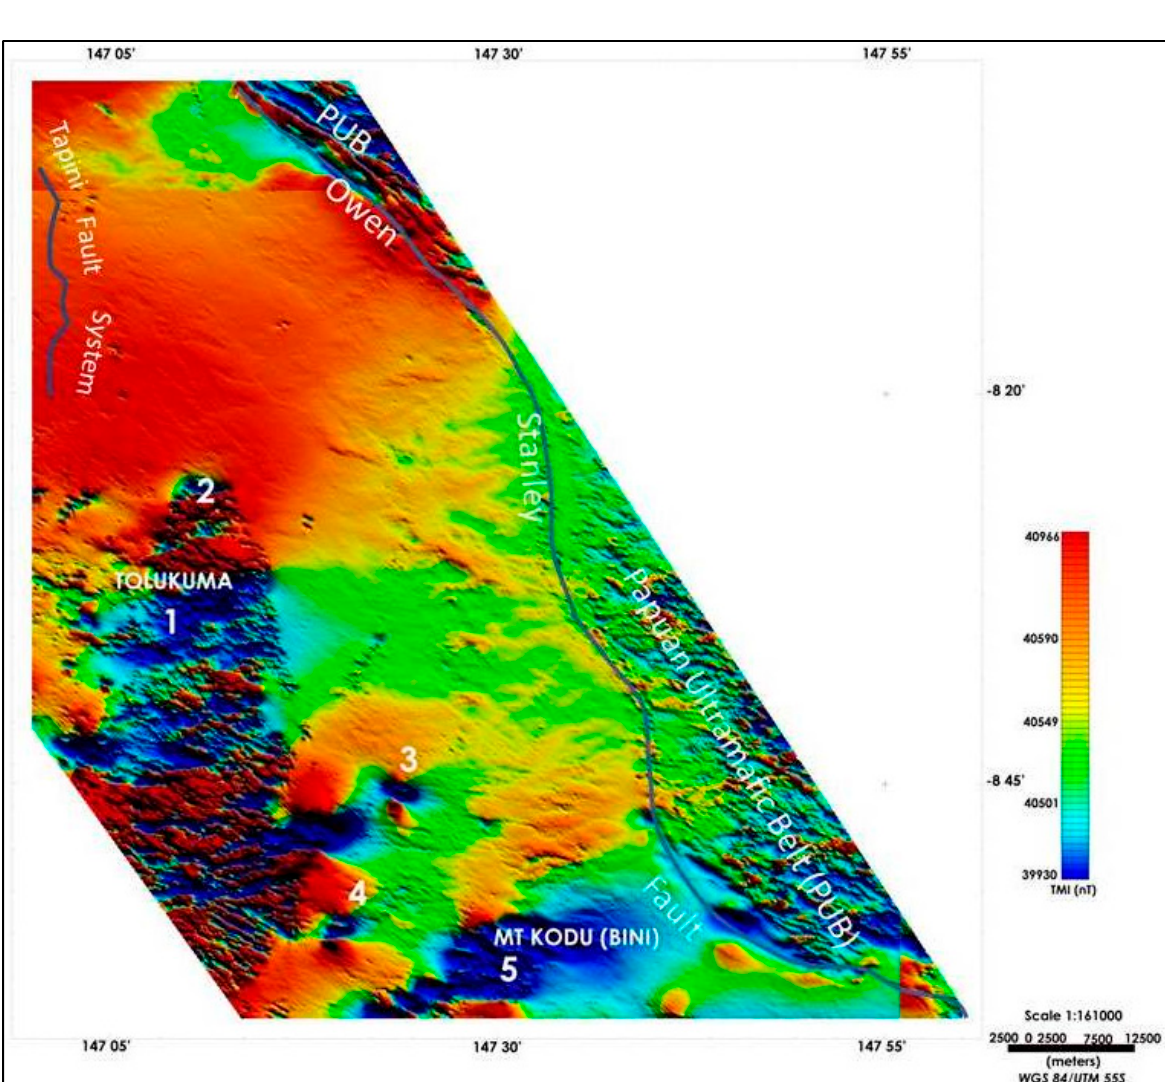
Figure 3. Total magnetic intensity reduced to the equator image of the study area. Magnetic anomalies of interest are numbered (1 − 5) and are referred to in the proceeding discussions.